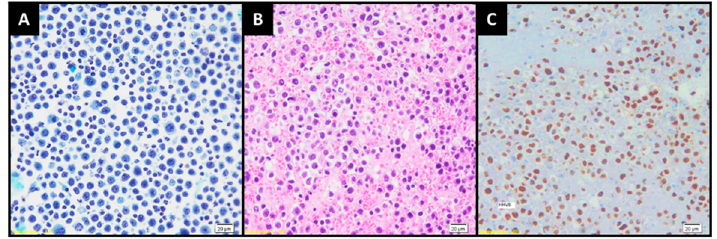
Figure 2. Cytological analysis of pleural fluid showing: ( A ) mononuclear cells with a monotonous